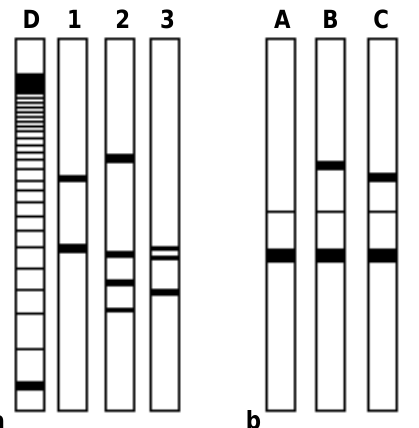
Figure 4 - Schematic drawing of micro 11 patterns. a) Species-specific pat- terns: D, 123-bp DNA ladder; 1, Gymnotus carapo ; 2, G. inaequilabiatus ; 3, G. pantherinus. b) The three micro 11 patterns obtained for G. sylvius.